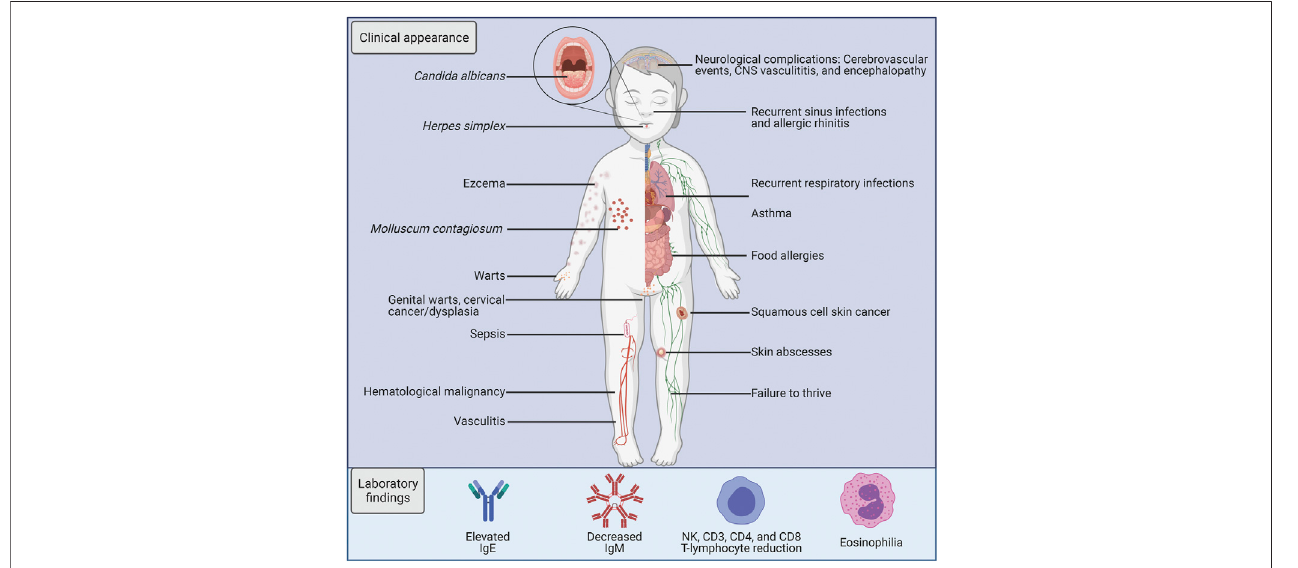
FIGURE 3 | Characteristics of DOCK8 de fi ciency. A schematic illustration listing the key clinical and laboratory fi ndings in DOCK8 de fi ciency patients.